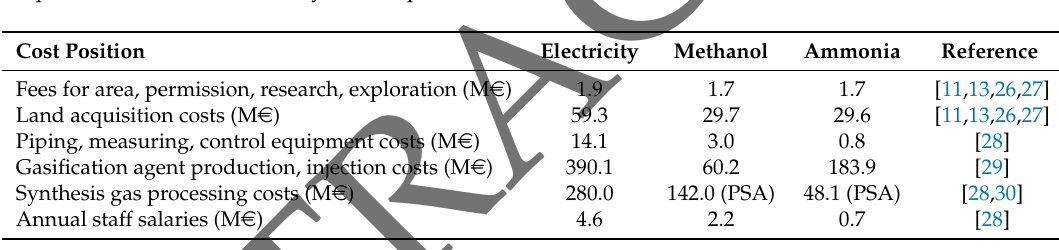
Table 4. Onshore UCG cost positions of the onshore electricity as well as methanol and ammonia production scenarios for 20 years of